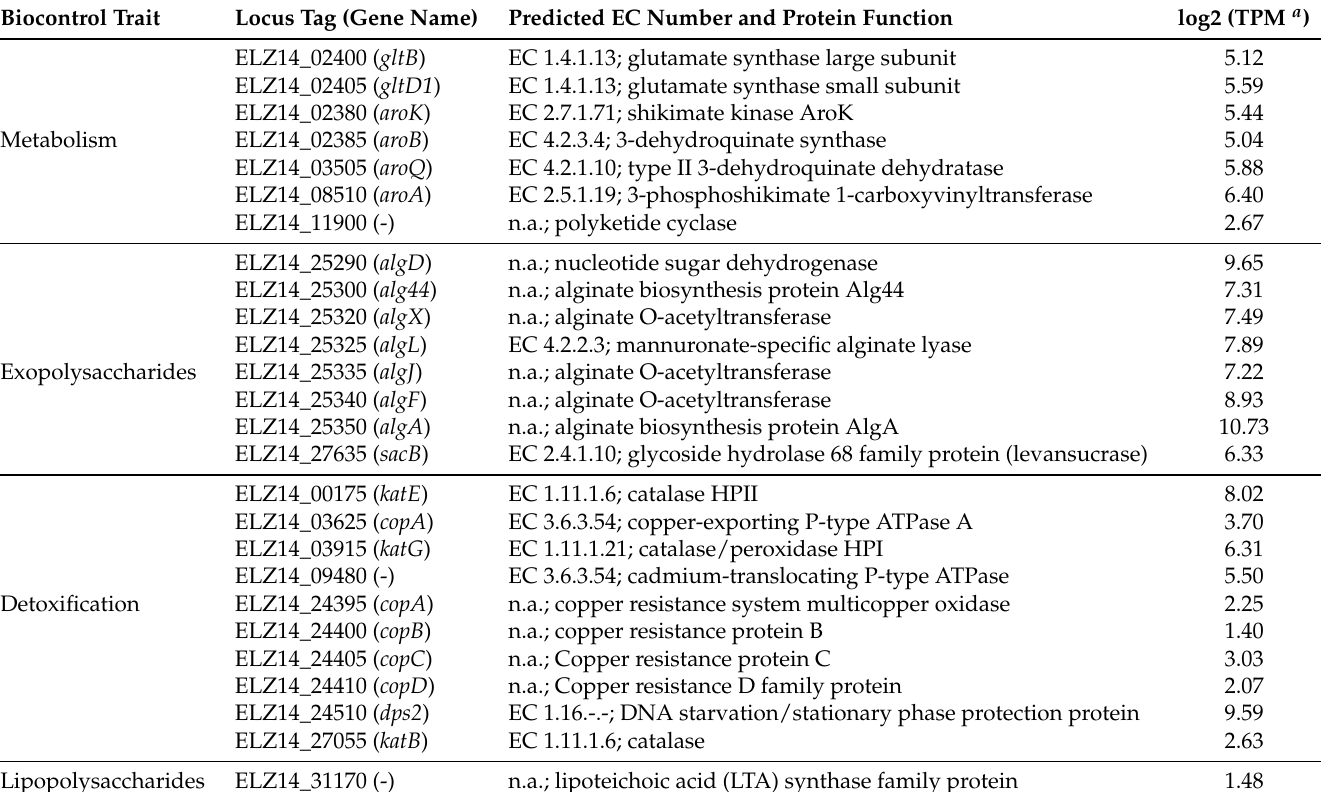
Table 8. Genetic biocontrol determinants of P. brassicacearum